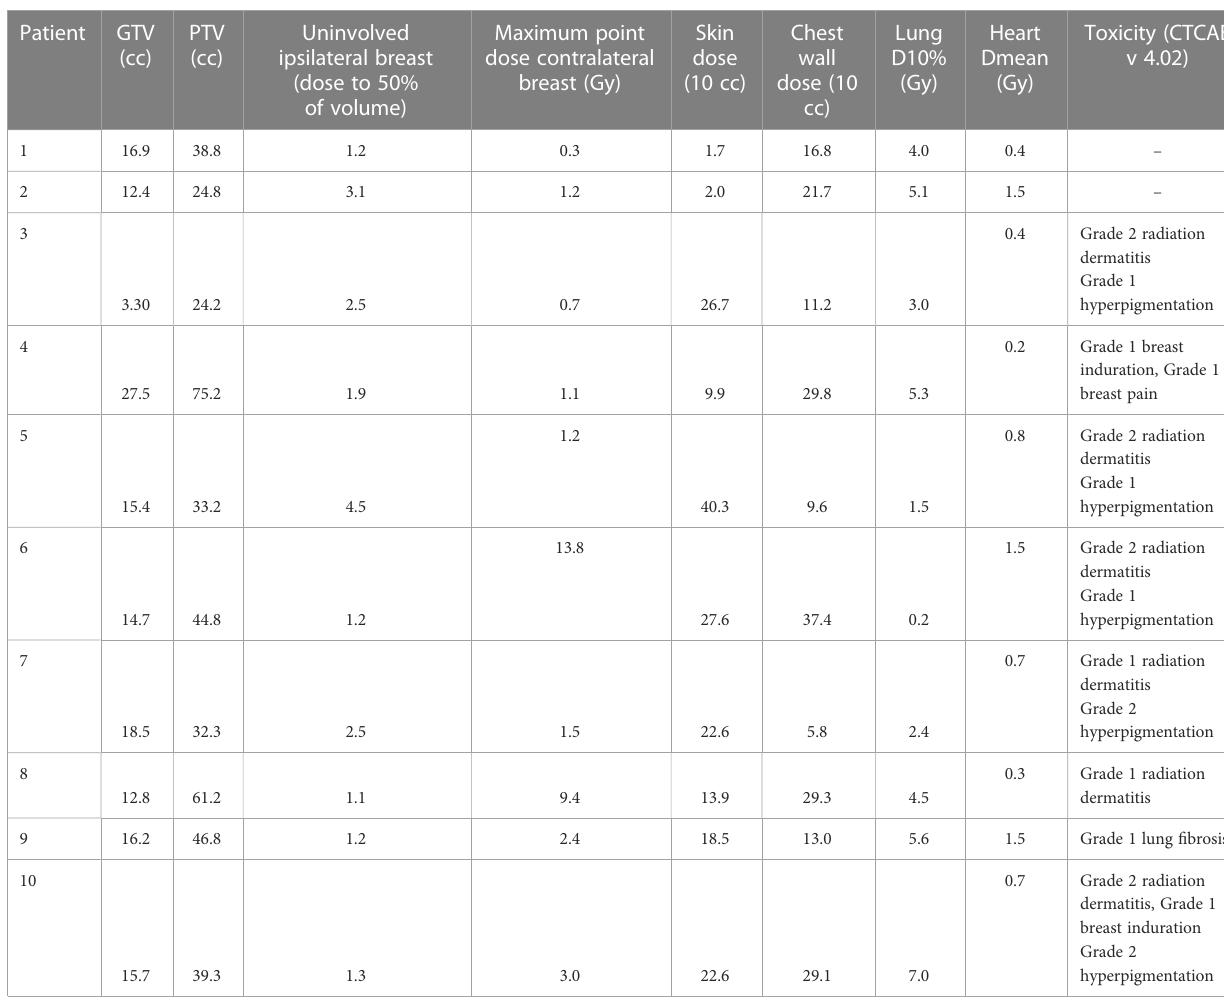
TABLE 2 Planning data and toxicity description.